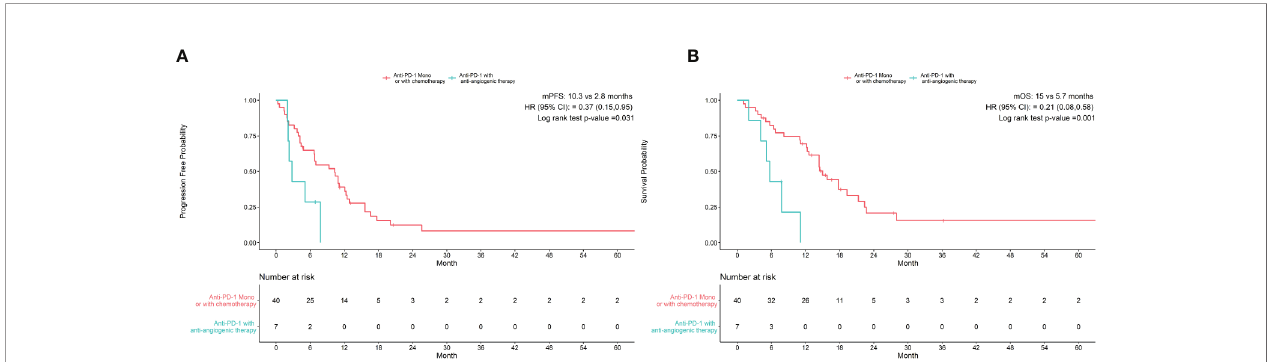
FIGURE 2 | Treatment type associated with progression-free survival (A) and overall survival (B) in patients with normal Hb levels.